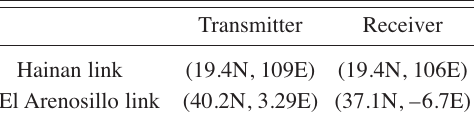
Table I. Transmitter and receiver geographic coor-